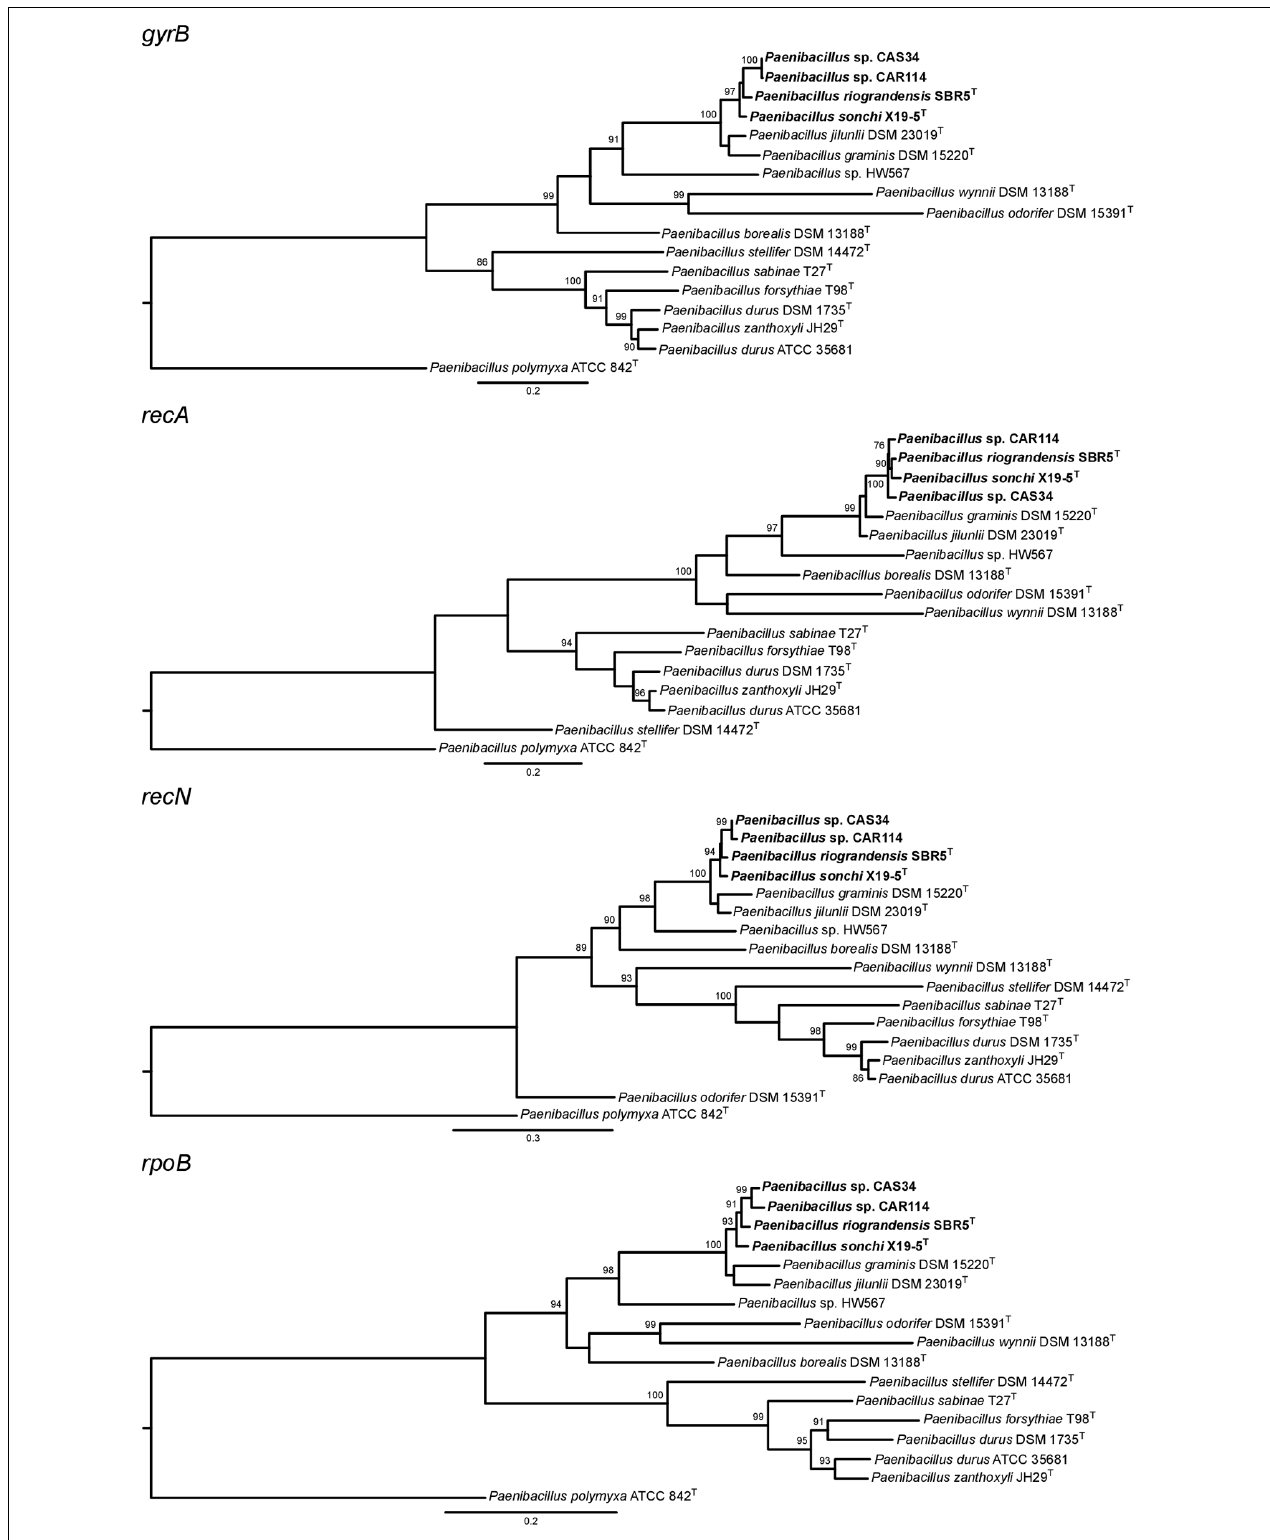
FIGURE 5 | Phylogenies of genes other than 16S rRNA gene of Paenibacillus species. The trees were built using the maximum-likelihood method. Details are as shown in Figure 1 , unless specified otherwise.